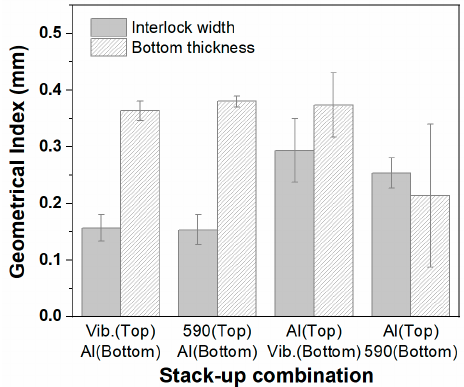
Figure 15. Comparison of geometrical indices of SPR joints (fabricated by type A1 die) for different stack-up combinations.